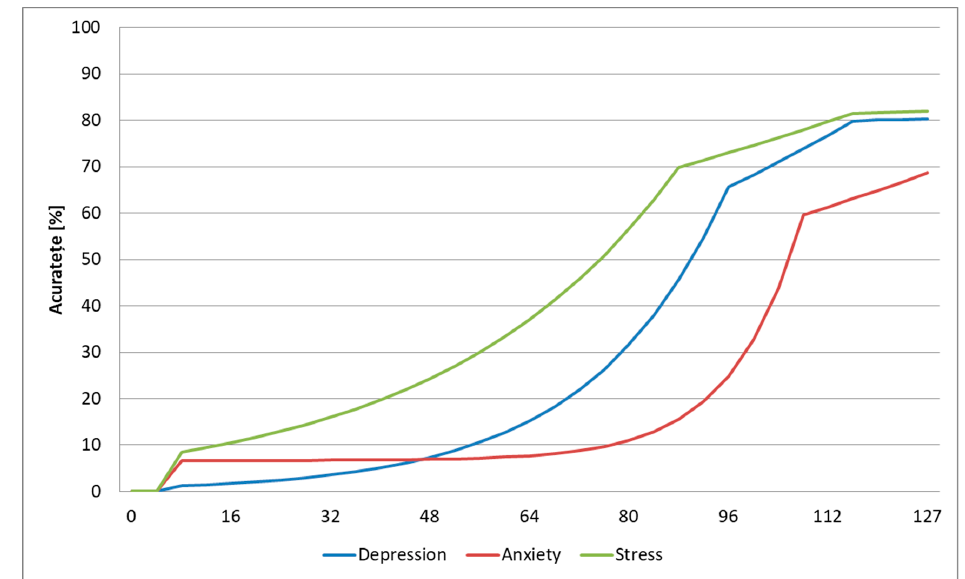
Figure 16. Prediction accuracy based on the number of subjects used for training (intersubject methodology).